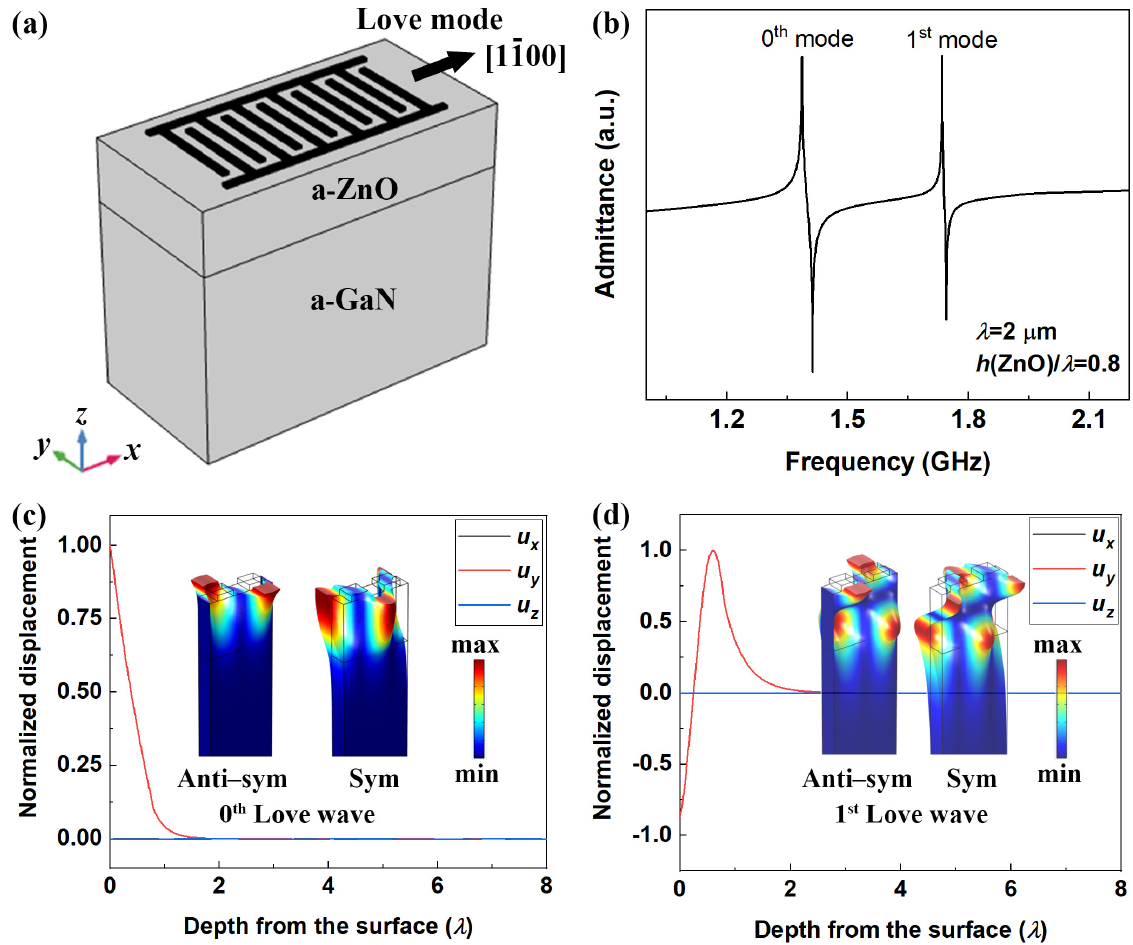
Figure 1. A typical admittance response ( b ) and its corresponding displacement curves and deformation shapes ( c , d ) of the SAW devices based on the a-ZnO/a-GaN structure ( a ) where Love-mode waves are excited.